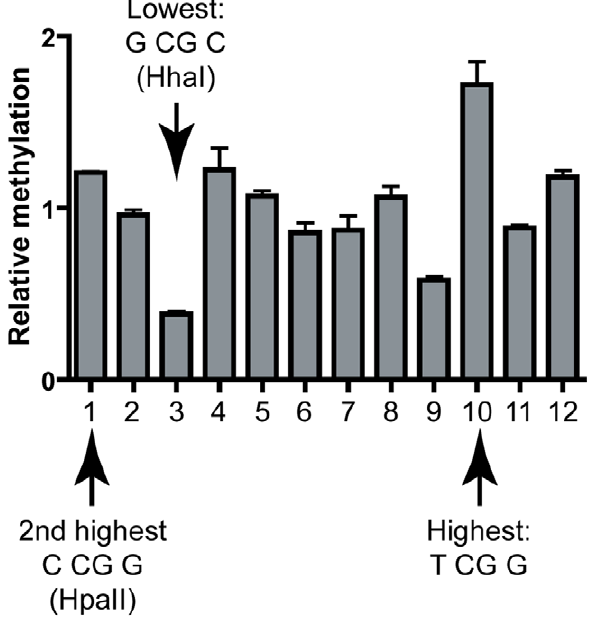
Figure 5. Validation of the DNMT3B sequence preference at the human TIMELESS CpG island. The methylation frequencies observed at each CpG site are shown relative to the average frequency observed for the region ( i.e. a value of 2 would indicate that the frequency at a given site is two-fold above average). Each bar represents the average of three independent experiments; error bars indicate standard deviation. Hotspots and coldspots are indicated and are as expected from the sequence preferences derived from test regions.